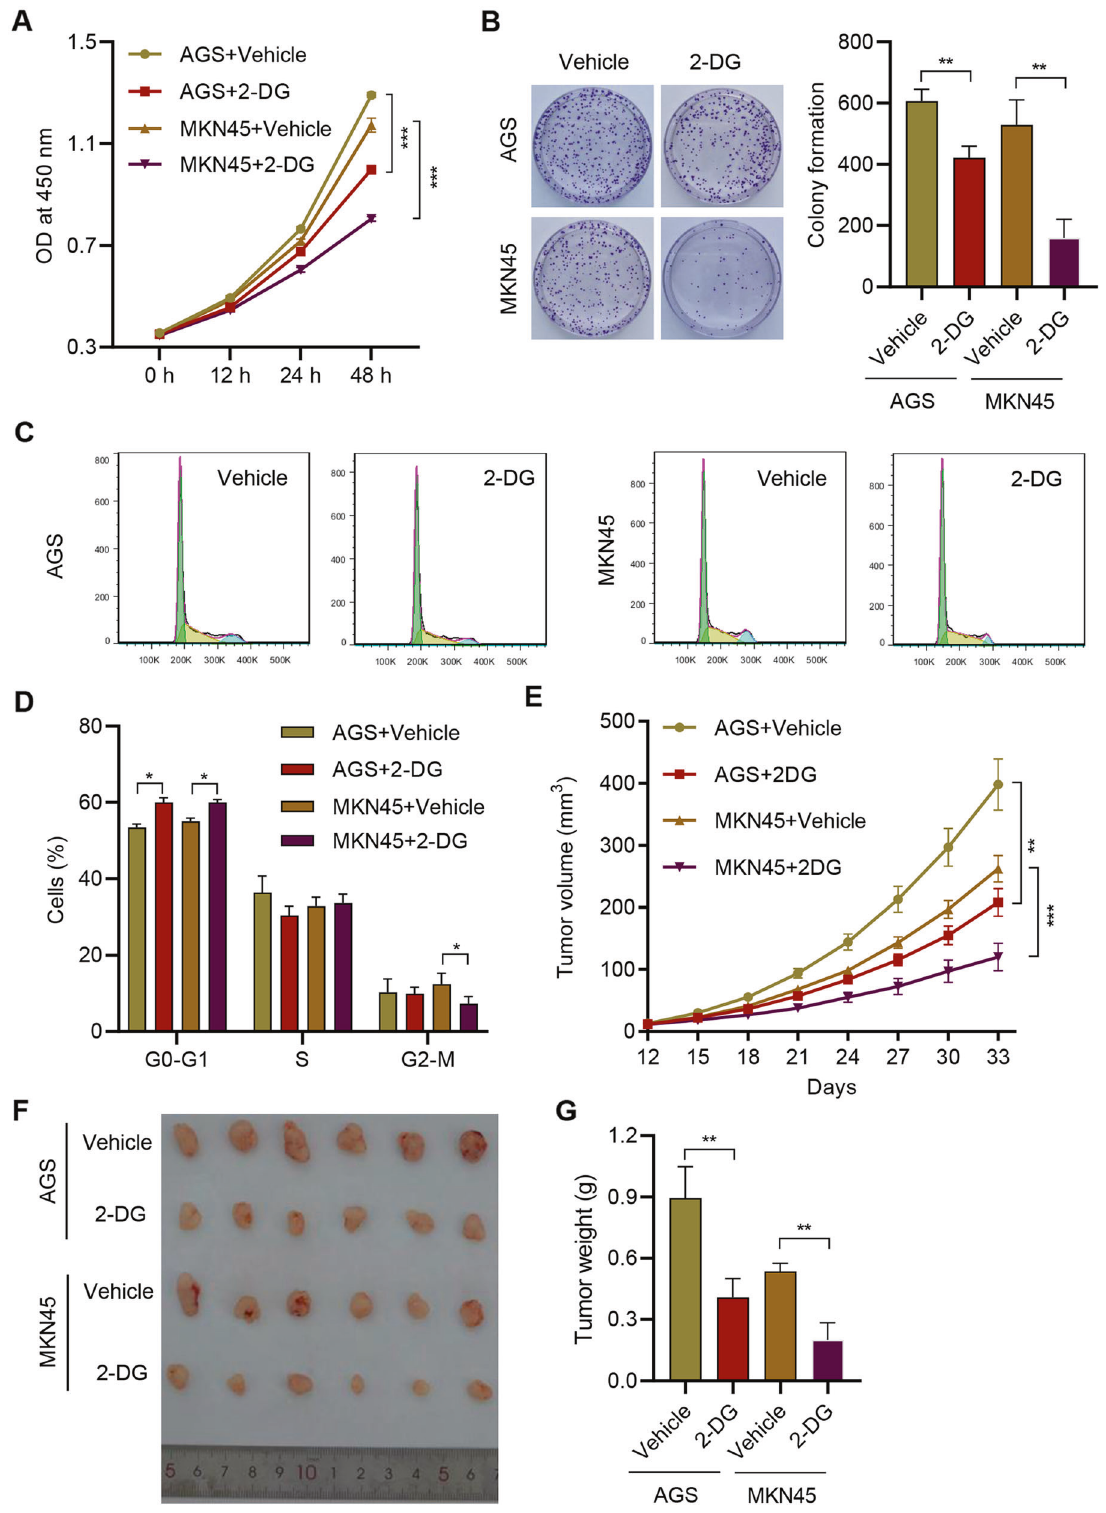
Fig. 5 Inhibition of glycolysis exerted anti-tumor effects against GC. A Cell viability, ( B ) colony formation and ( C , D ) cell cycle of AGS and MKN45 cells treated with 10 mM 2-DG or vehicle. AGS or MKN45 cells were subcutaneously injected into the mice with or without 100 mg/kg 2-DG treatment. E Tumor volume was estimated. F The photograph of tumors. G Tumor weight in each group. ** P < 0.01, *** P <